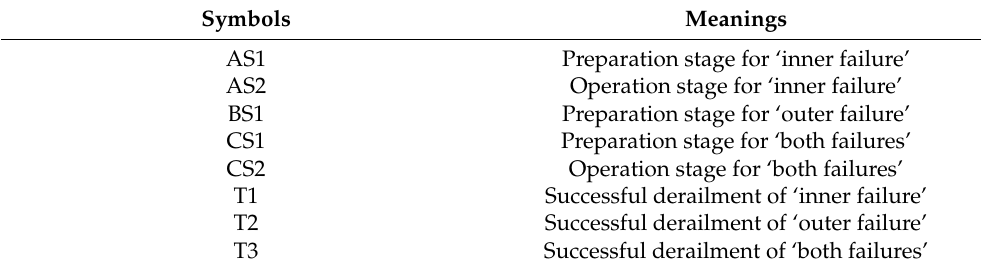
Figure 5. An illustration of the graphical model (please refer to Tables 1 and 3 for the meanings of the symbols). Table 3. Train derailment for the different failures and their safety